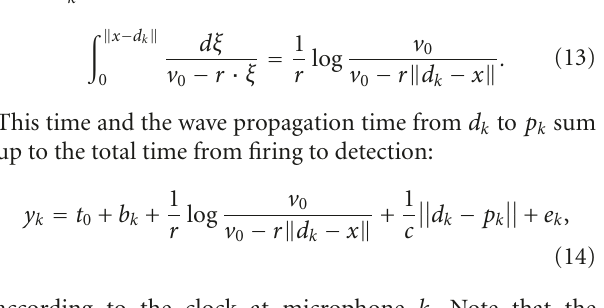
Figure 2: Level curves of the muzzle blast localization criterion based on data from a field